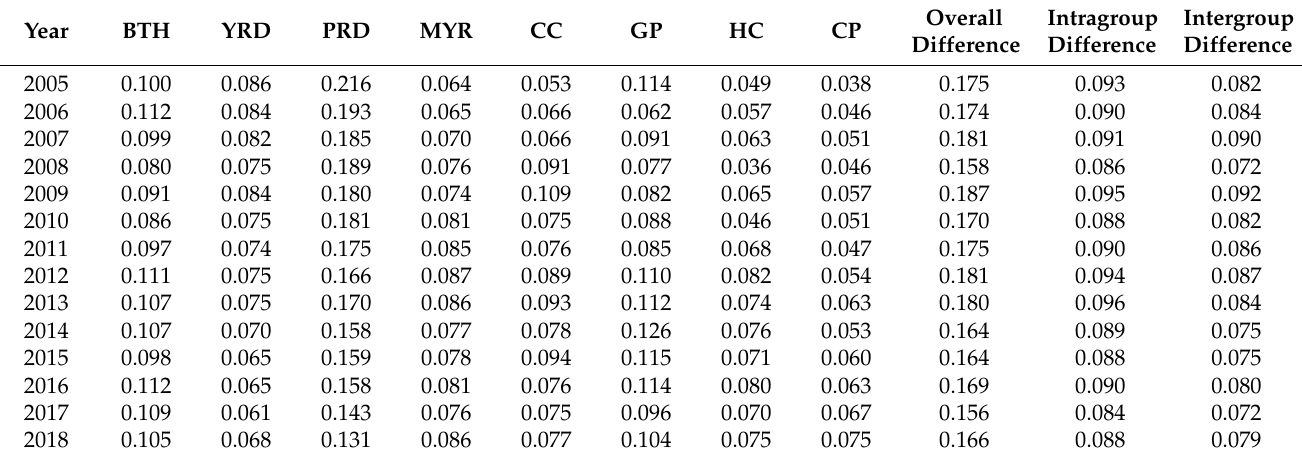
Table 3. Spatial differences in urban resilience of the eight urban